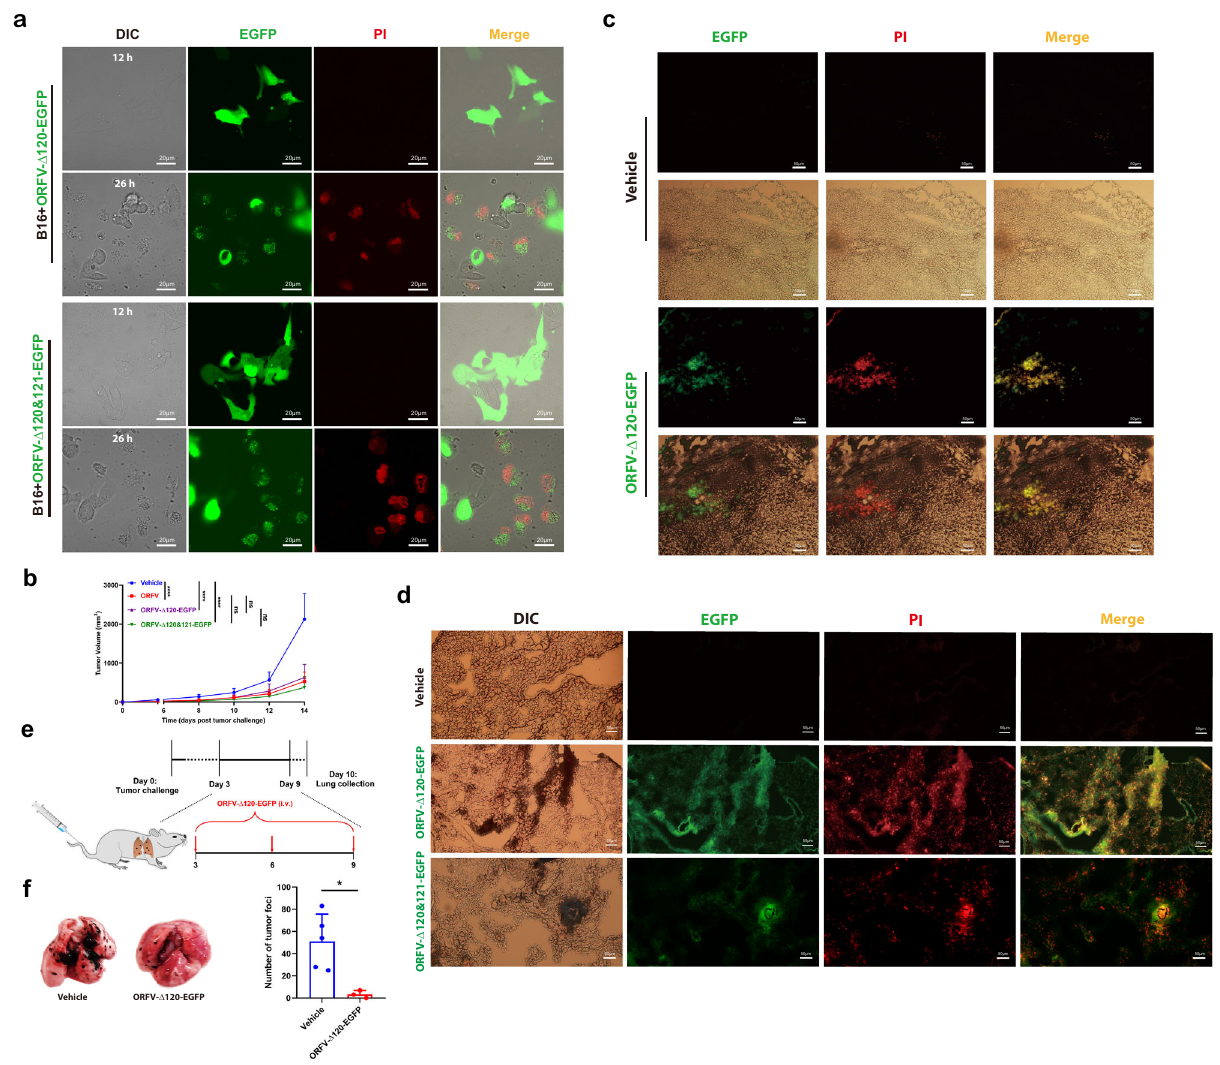
Fig. 5 | ORFV recombinants trigger, replicate, and cause pyroptosis in tumor cells. a Images acquired with a fl uorescence microscope display the replication of ORFV- Δ 120-EGFP (MOI=1) and ORFV- Δ 120-121-EGFP (MOI=1) in B16 cells for 12h through the EGFP signal. Pyroptotic cell death were displayed through PI uptake signal for 26h (scale bar: 20 μ m). b Six weeks old male C57BL/6 mice were s.c. engrafted with B16 cells and i.t. treated with vehicle, ORFV (1×10 5 TCID 50 /mouse), ORFV- Δ 120-EGFP (1×10 5 TCID 50 /mouse) and ORFV- Δ 120-121-EGFP (1×10 5 TCID 50 / mouse) ( n =7 – 8). Tumor volume were measured as indicated time